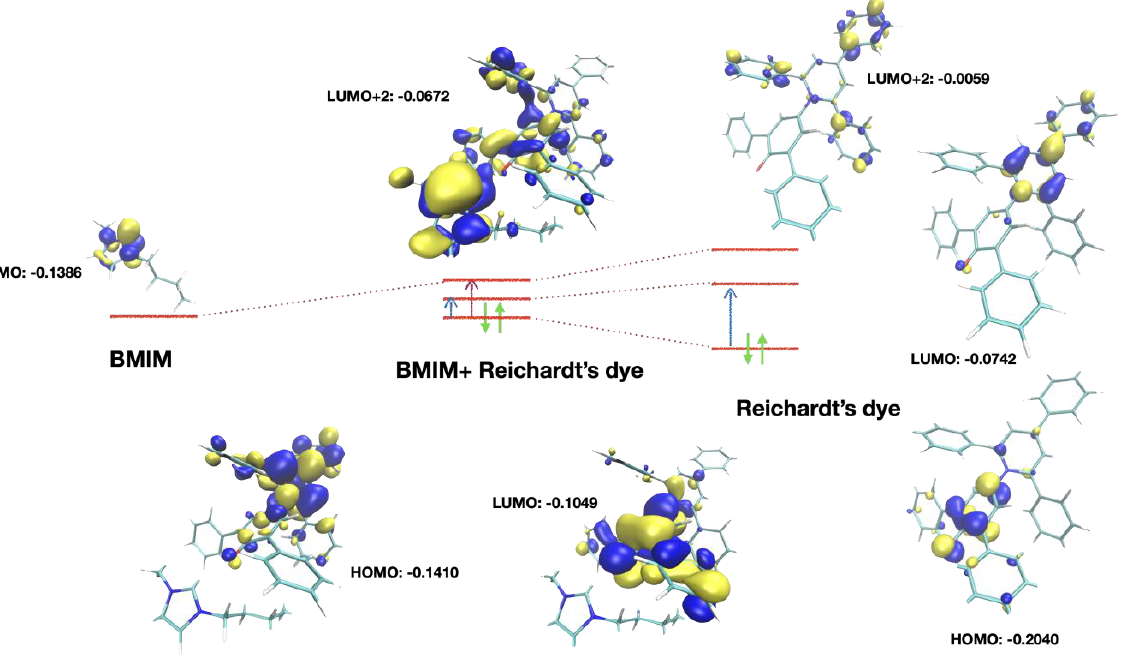
Figure 6. Orbitals involved in the transitions. Right: free Reichardt’s dye. The HOMO ➝ LUMO transition (blue arrow) involved an internal charge transfer. In the dye-cation cluster, the LUMO + 2 orbital mixed with the LUMO of the cation, leading to shared orbitals where there was dye-cation charge transfer (purple arrow). The actual transition also involved LUMO + 3 and LUMO + 4 orbitals, similar to LUMO + 2, but they were not reported here.